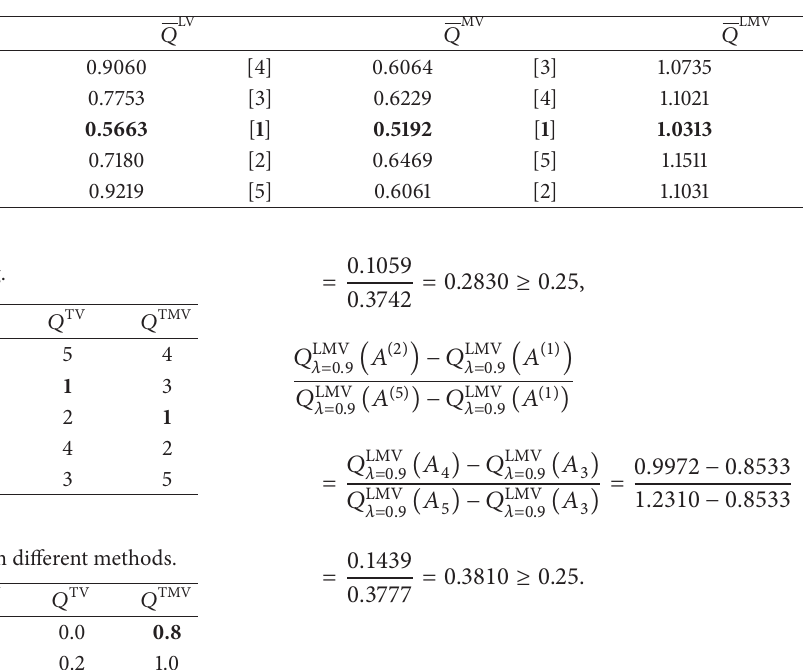
V LV MV LMV , 𝑄 , 𝑄 , and 𝑄 .